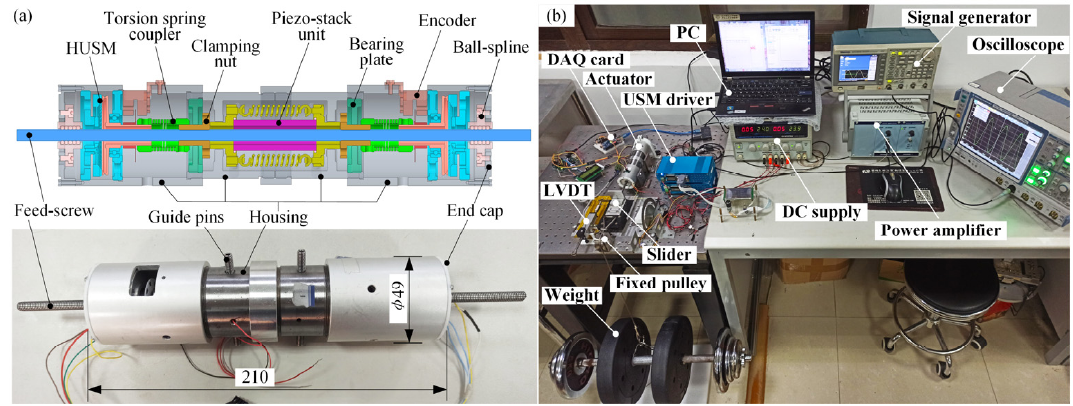
Figure 3. Prototype and experimental setup. ( a ) Prototype; ( b ) setup.